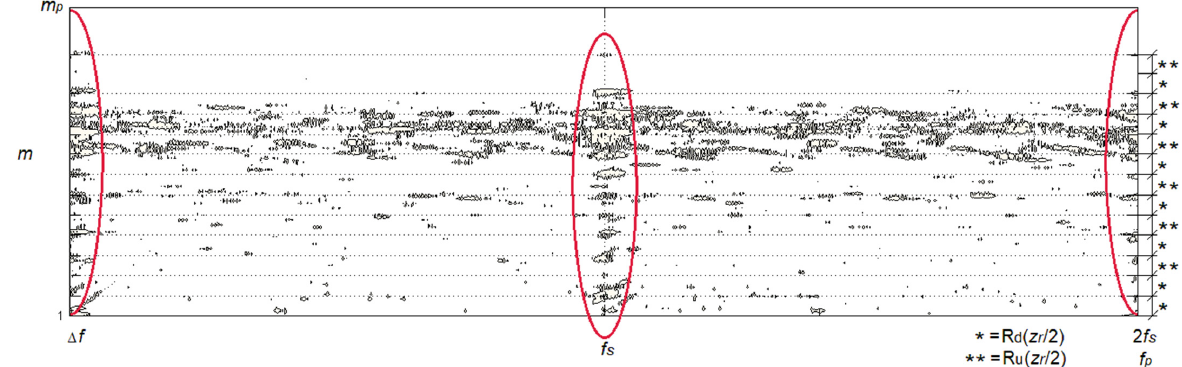
Figure 4. F-F image of the frequency spectrum of the vibration acceleration of the outer casing of a healthy motor with marked reference-like pattern associated with rotor grove-tooth frequency. R d is the rounded down and R u is the rounded up number operation.